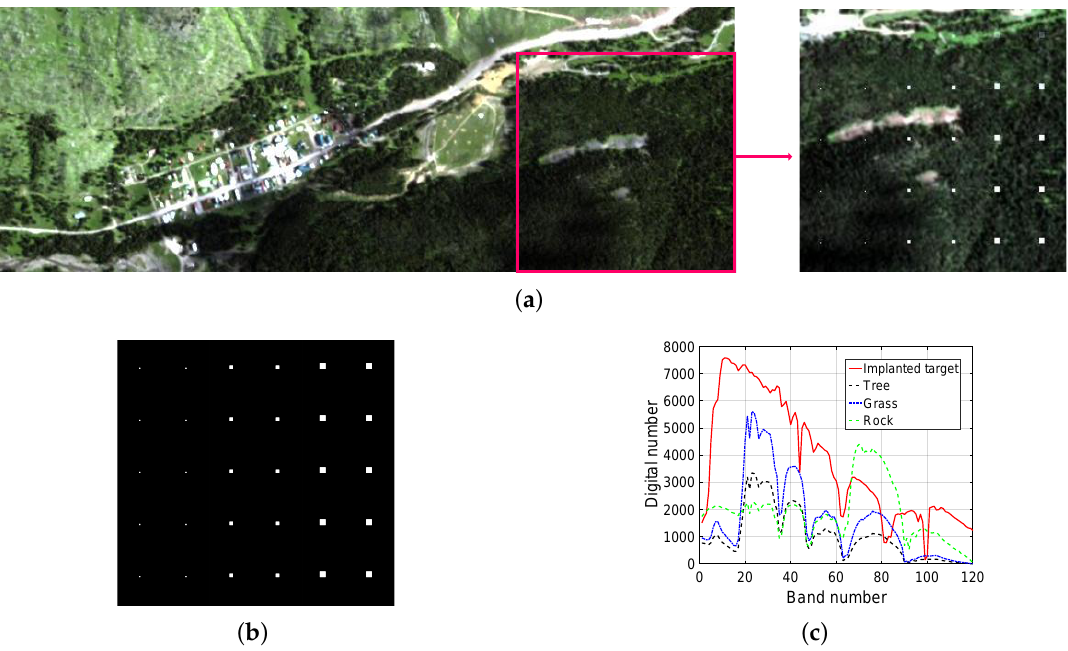
Figure 4. Synthetic dataset. ( a ) Pseudo-color image of the scene; ( b ) Ground-truth map; ( c ) Spectral curves of implanted target and main